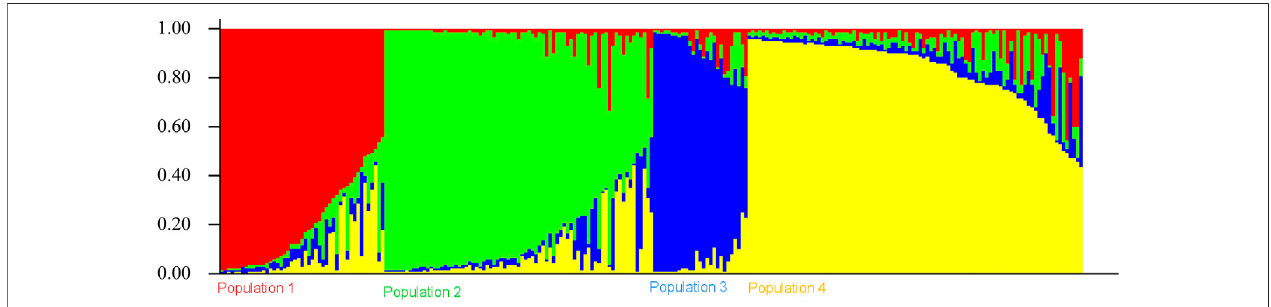
FIGURE 8 | Population structure bar plot of the east coast core